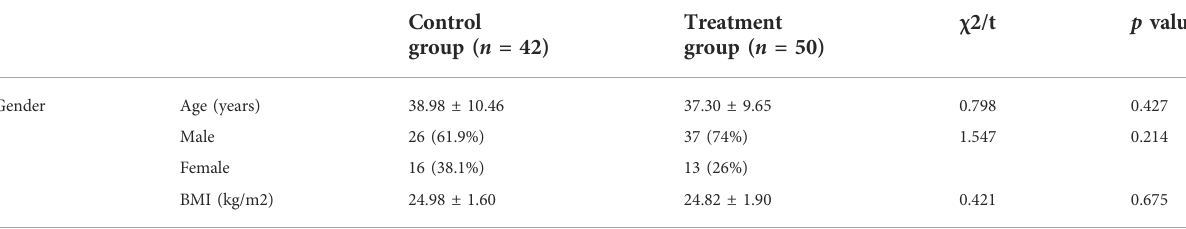
TABLE 1 Baseline characteristics of patients.